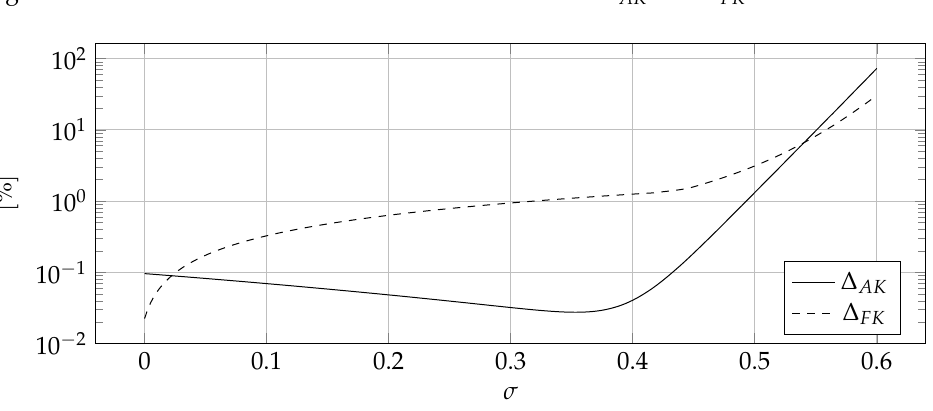
Figure 11. The influence of σ coefficient on ∆ AK , ∆ FK error